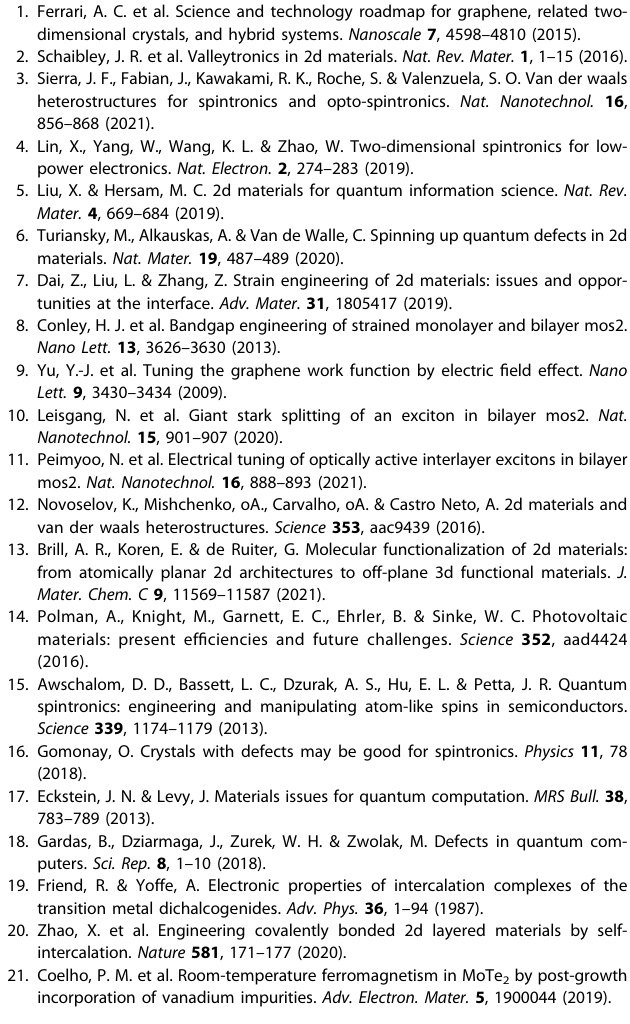
The FFT grid column show the size compared to the largest wave